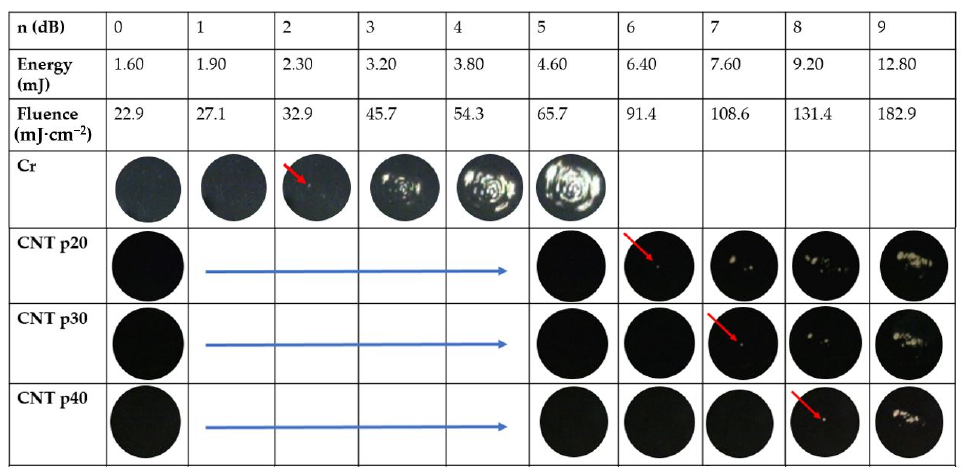
Figure 10. Microscopic images of CNT-based transmitters and Cr film (reference) after laser pulse excitation. Input laser energy and fluence are shown in the second and third row, respectively. The red arrows indicate the initiation point of ablation for each transmitter. The ablation was not observed for CNT p20–p40 when the optical fluence was lower than 65.7 mJ·cm − 2 (images not shown).